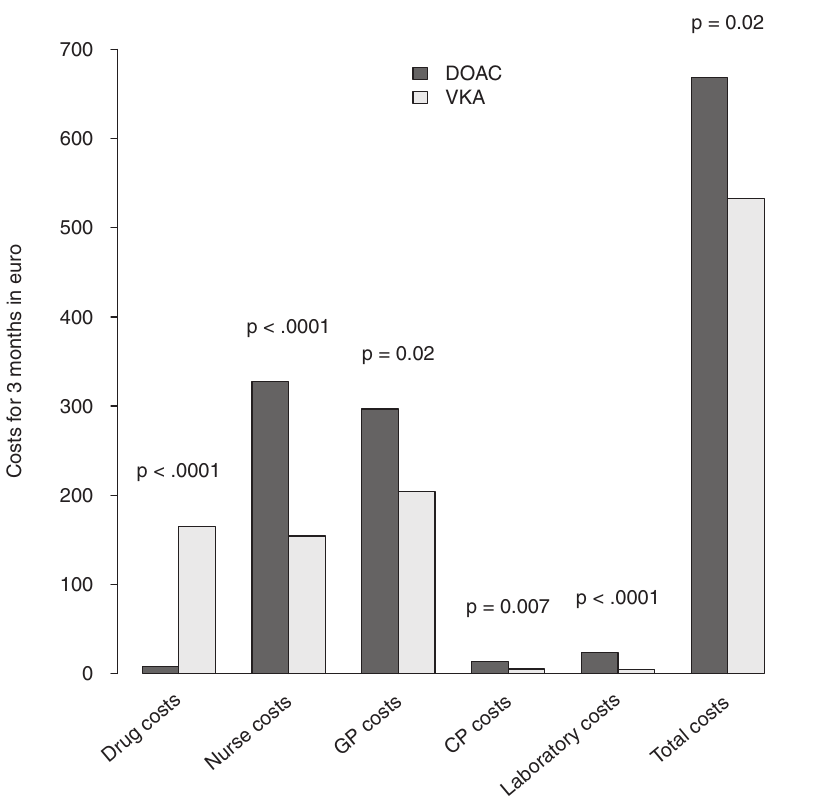
Fig 1. Detailed and overall costs of DOAC and VKA treatments for 3 months. VKA, vitamin K antagonists; DOAC, direct oral anticoagulants; GP, General practitioner; CP, coordinating physician.